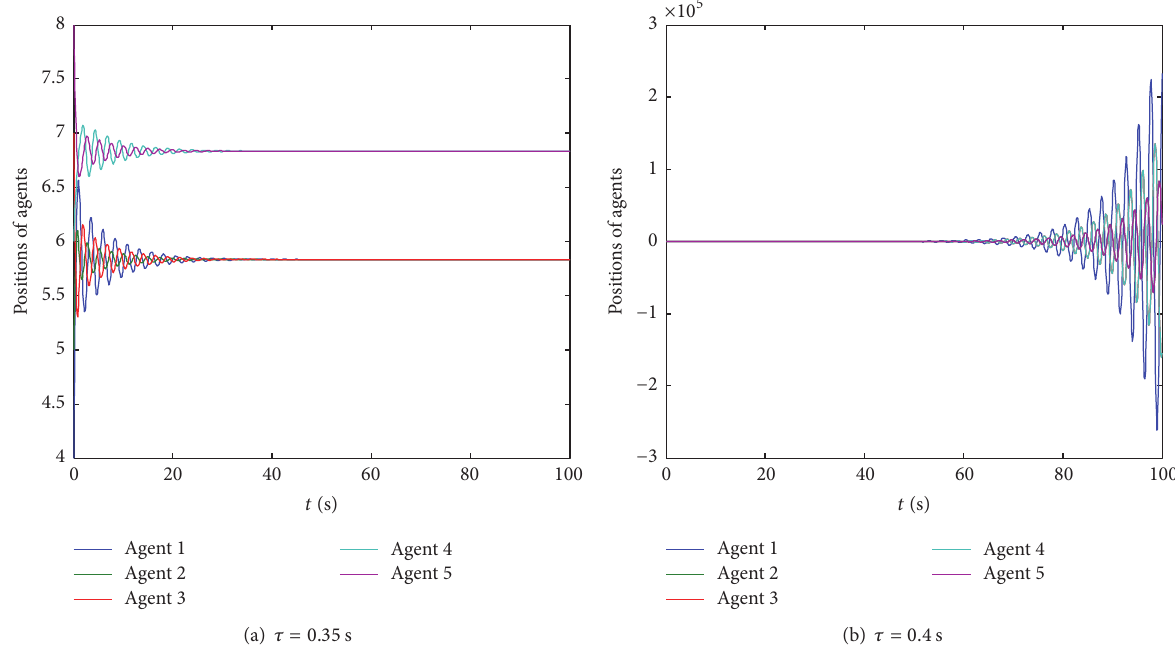
Figure 6: State trajectories of the agents in the networks (11) when 𝑇 𝑖 = 𝜏